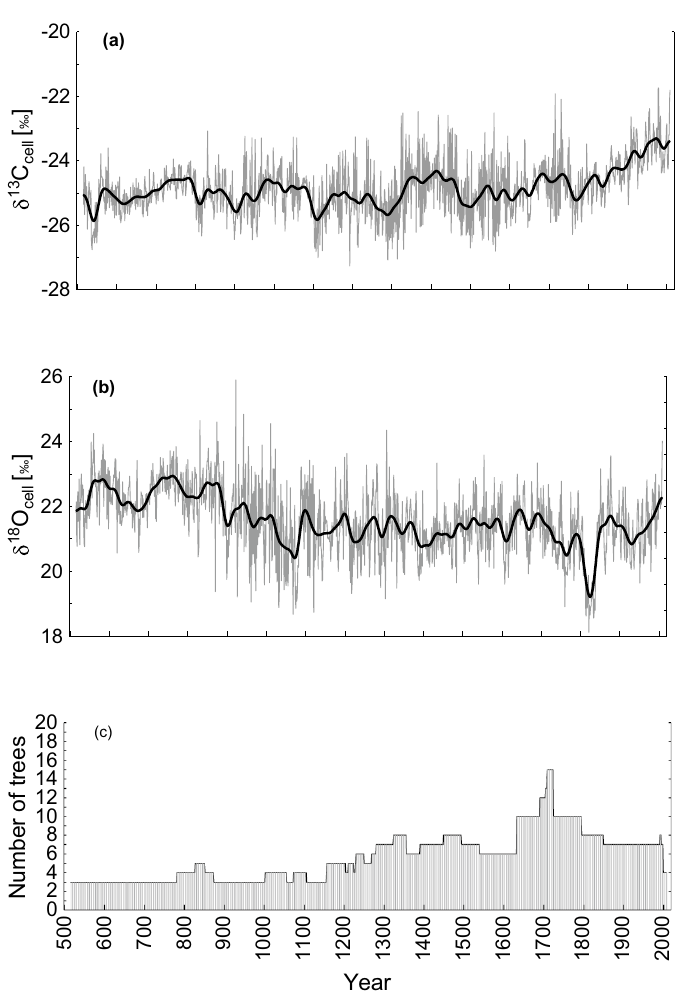
Figure 1. Annually resolved (grey) and smoothed by a 41-year Hamming window (bold black) stable carbon δ 13 C cell ( a ) and oxygen (δ 18 O cell ) ( b ) isotope chronologies. Number of trees ( c ) used for both δ 13 C cell and δ 18 O cell